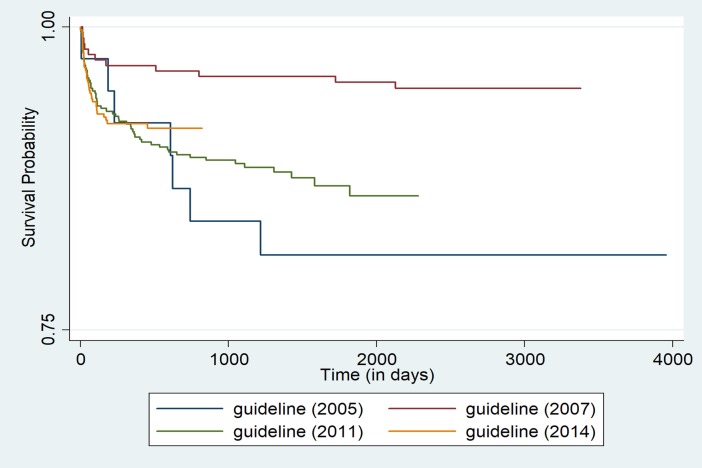
Unadjusted Kaplan-Meier survival curves for treatment outcome of HIV positive children who receiving ART in Mingalardon Specialist Hospital by guideline (2006 to 2016).Log rank test chi2 p-value: 0.0042.